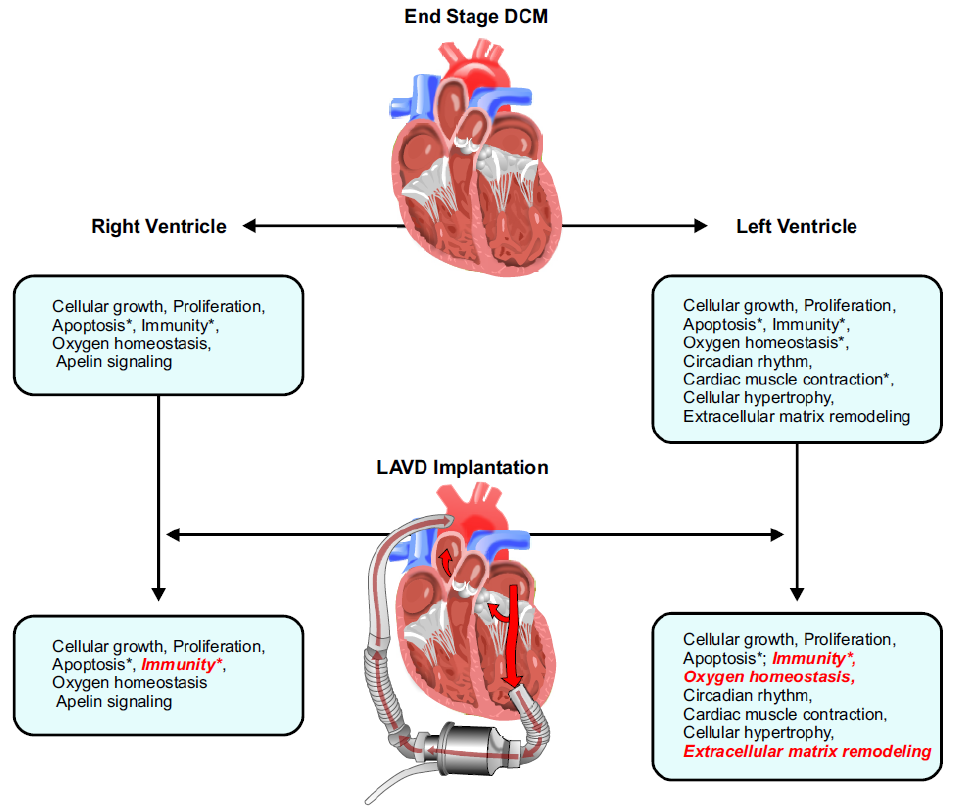
Figure 7. Summary of the findings from this study illustrating the seminal impact of LVAD therapy on reverse remodelling in the left ventricle and right ventricle. Processes that were normalized are italicized in red, and an asterisk (*) indicates pathways where the concerned genes also had corresponding changes at the miRNA level. DCM, dilated cardiomyopathy; LVAD, left ventricular assist device.